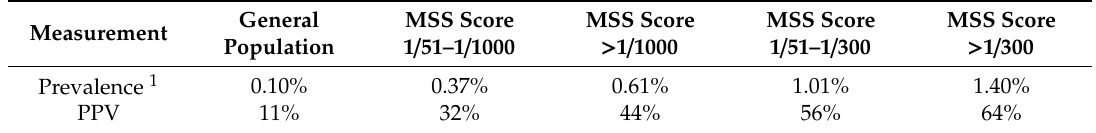
Table 4. PPVs based on the prevalence of ACAs and the MSS risk